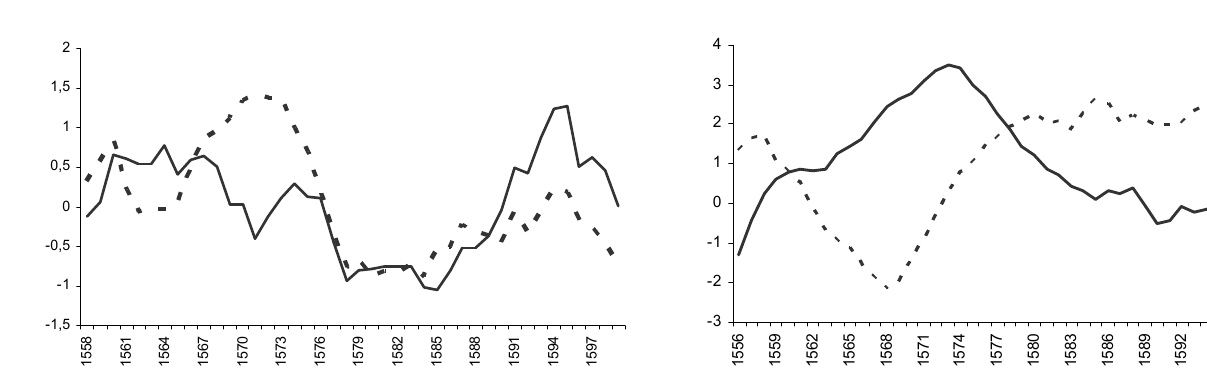
Figure 4. Standard five-year moving average curves of floods (solid line) and precipitation (broken line). For both basins, Y-axis = deviation from normal values; X- axis = years.